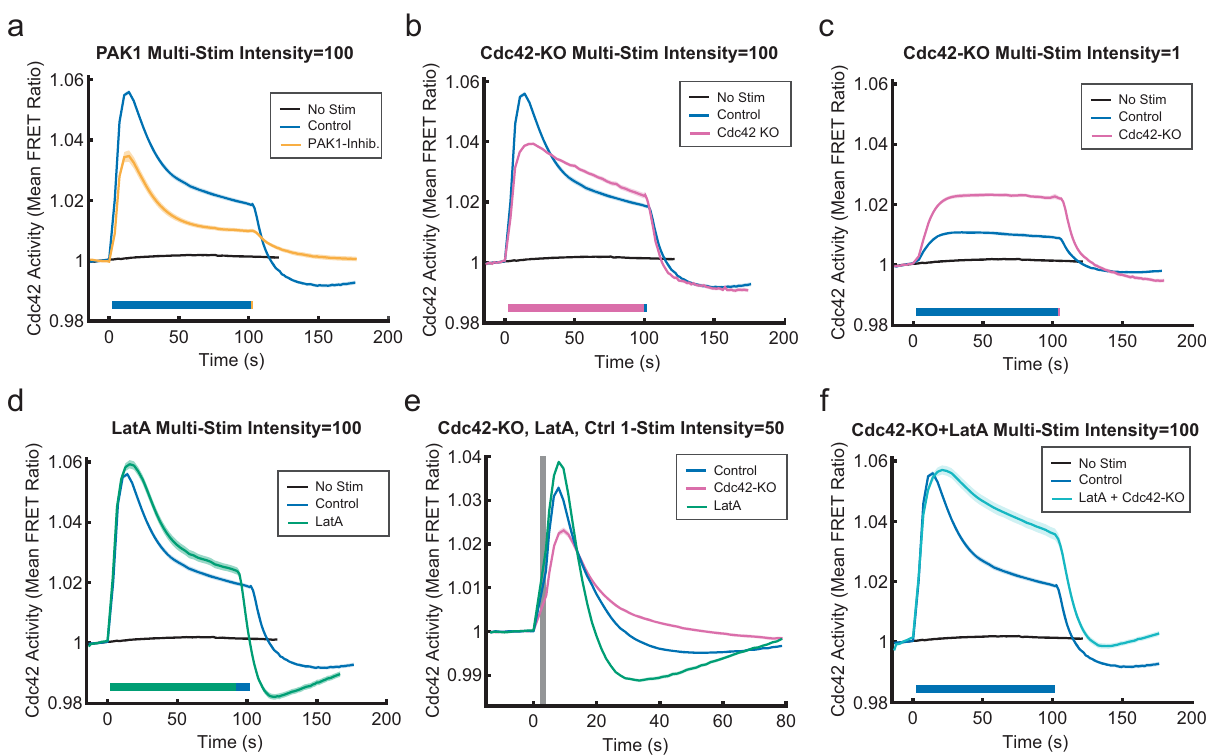
Fig. 6 Multiple negative signals downstream of G proteins collaborate to regulate the Cdc42 response. a Comparison of Cdc42 responses to prolonged stimulation with or without treatment with 5 μ M PAK1 inhibitor IPA-3. Data are presented as mean ± s.e.m. ( n well replicates = 65 for non-stimulated, n = 77 for control, and n = 32 for PAK1 inhibited). Relative light intensity = 100. Stimulation duration is indicated by color bars. b Comparison of Cdc42-TomKat sensor response measurements under the same conditions for Cdc42-KO cells and control cells. Data are presented as mean ± s.e.m. ( n well replicates 65 for non-stimulated, n well replicates = 77 for control, and n well replicates = 56 for Cdc42-KO). Relative light intensity = 100. Stimulation duration is indicated by color bars. c Comparison of the responses of the same cell lines to lower power stimulations. Data are presented as mean ± s.e.m. ( n well replicates = 65 for non-stimulated, n well replicates = 27 for control, and n well replicates = 16 for Cdc42-KO). Relative light intensity = 1. Stimulation duration is indicated by color bars. d Comparison of Cdc42 responses to prolonged stimulation with or without treatment with 1 μ M of the actin-depolymerizing agent Latrunculin-A (LatA). Data are presented as mean ± s.e.m. ( n well replicates = 65 for non-stimulated, n well replicates = 77 for control, and n well replicates = 25 for Latrunculin-A-treated cells). Relative light intensity = 100. Stimulation duration is indicated by color bars. e Comparison of single- pulse stimulation responses for control cells, Cdc42-KO cells, and 1 μ M Latrunculin-A cells. Data are presented as mean ± s.e.m. ( n well replicates = 76 for control, n well replicates = 42 for Cdc42-KO, and n well replicates = 70 for Latrunculin-A-treated cells). Relative light intensity = 50. Stimulus duration indicated by gray bar. f Comparison of responses for untreated control cells and Cdc42-KO cells treated with 1 μ M Latrunculin-A. Data are presented as mean ± s.e.m. ( n well replicates = 65 for non-stimulated, n well replicates = 77 for control, and n well replicates = 32 for Latrunculin-A + Cdc42-KO cells). Relative light intensity = 100. Stimulation duration is indicated by color bars. Source data are provided as a Source Data fi